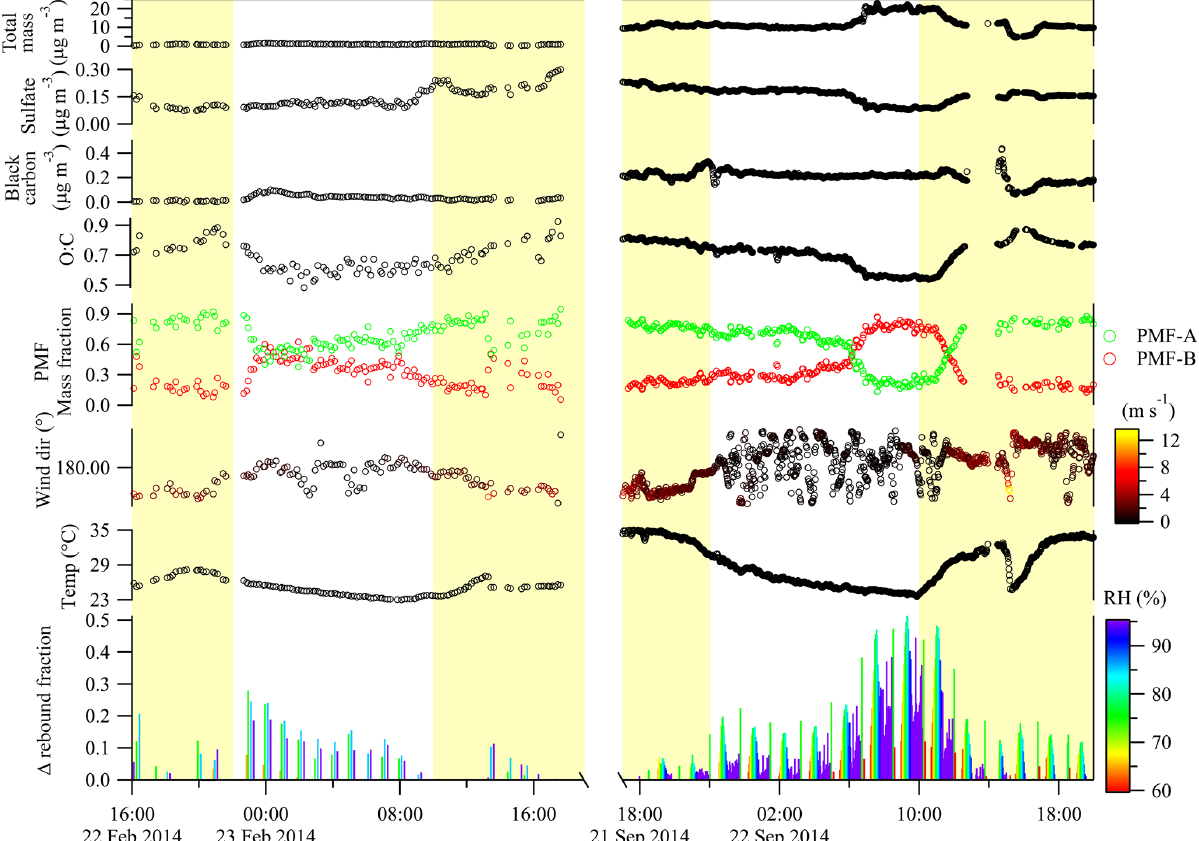
Figure 4. Time series of representative species during two pollution events for IOP1 and IOP2 (left and right sides of figures, respectively). Total mass concentration plotted in the figure represents the sum of the AMS and black carbon mass concentrations measured for submicron PM. The PMF mass fractions are expressed in relative terms to one another and necessarily sum to unity. Time on the abscissa is expressed in UTC.